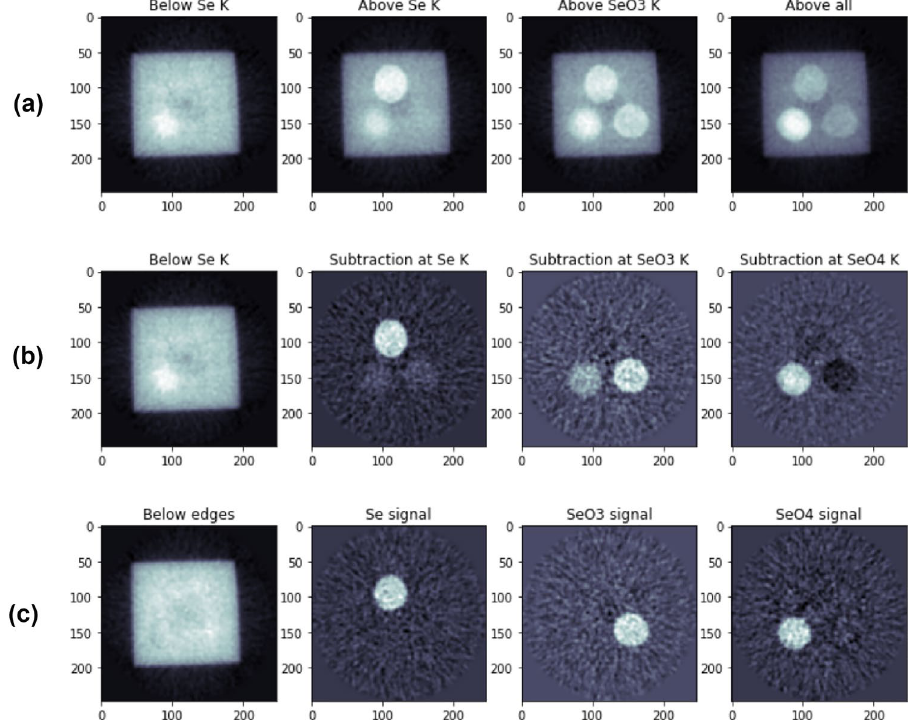
Figure 7. ( a ) Axial slices of the reconstructed tomograms acquired at energies A–D respectively from left to right; ( b ) separated Se signals by subtracting the tomograms with adjacent energies. From left to right, the first image is equal to the original tomogram at energy A, and the following ones are the differences B–A, C–B, and D–C, respectively; ( c ) separated signals using matrix inversion for the phantom without Se, Se(0), Se(IV), and Se(VI).